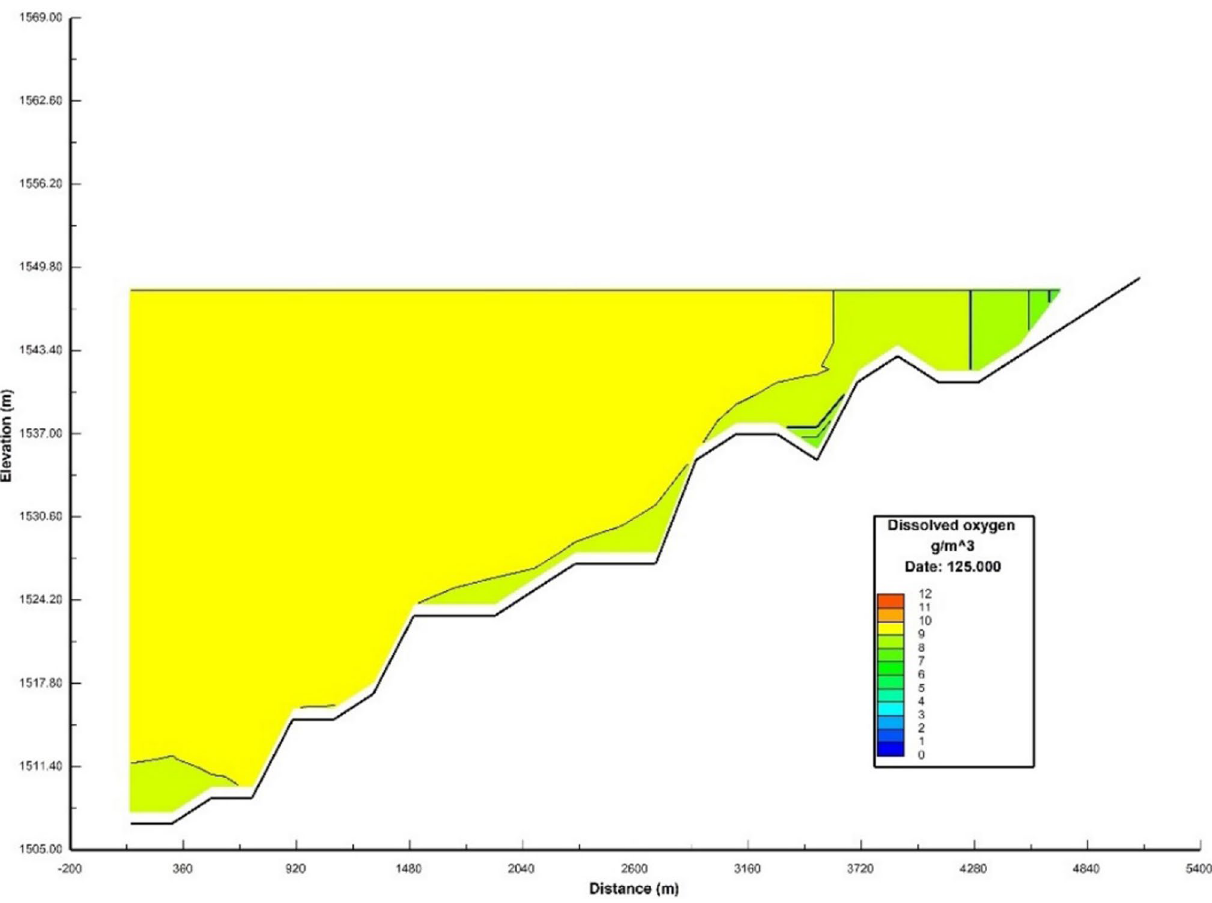
Fig. 8 The pattern of dissolved oxygen concentration in mid-May (Date: 5/15/2015)